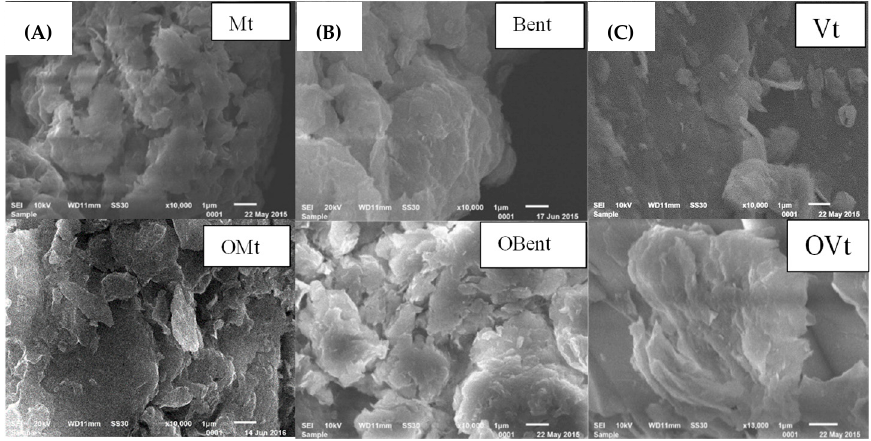
Figure 9. SEM images of ( A ) Mt, OMt, ( B ) Bent, OBent and ( C ) Vt, OVt.